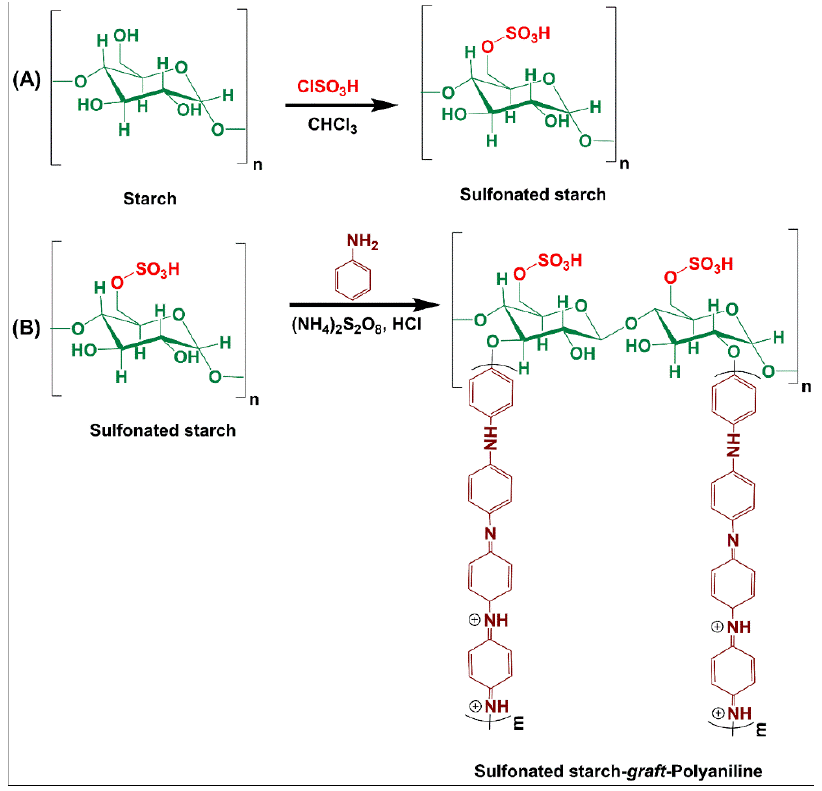
Figure 1. Preparation of sulfonated starch ( A ) and sulfonated starch-graft-polyaniline ( B ).